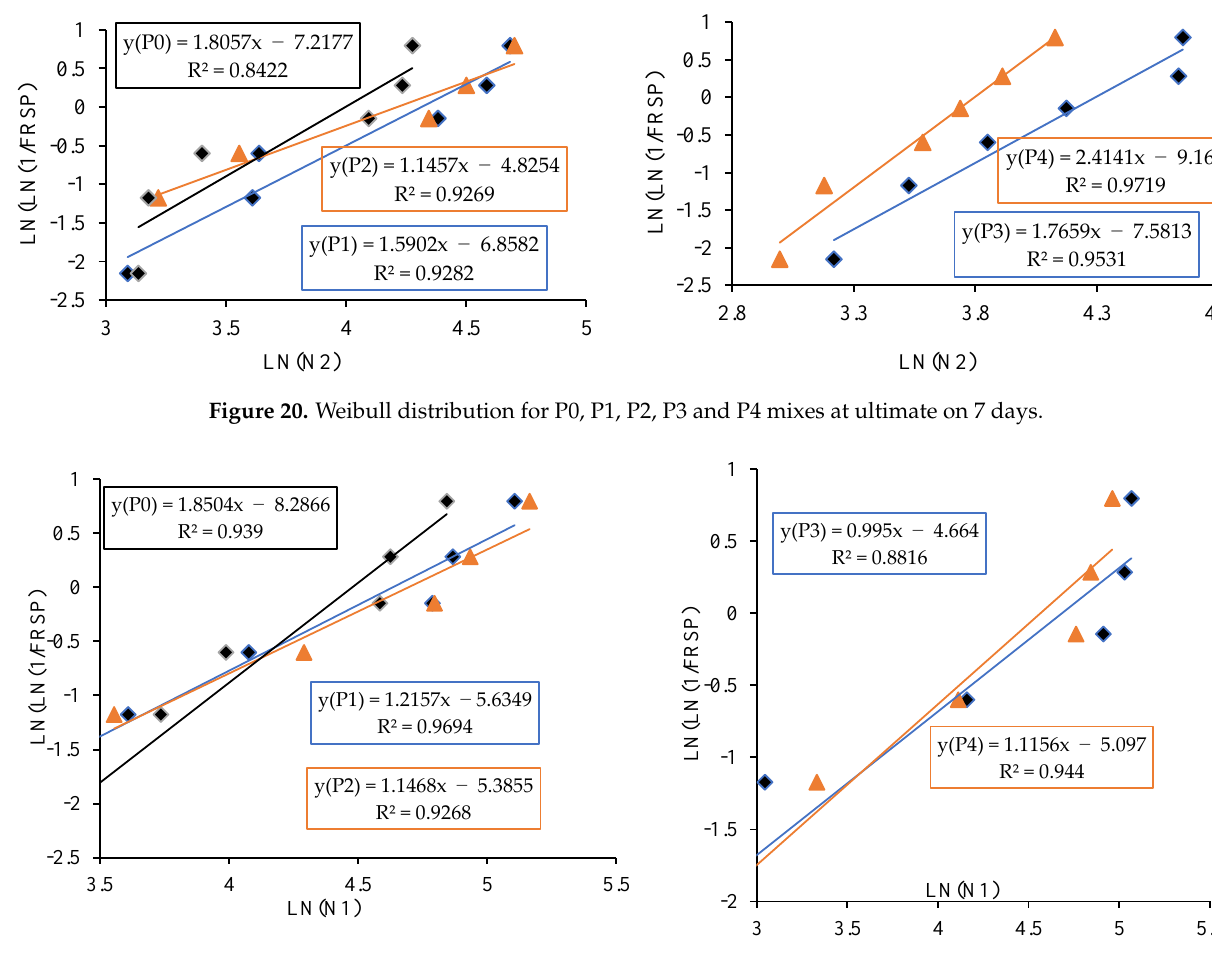
Figure 21. Weibull distribution for P0, P1, P2, P3 and P4 mixes at initial crack on 14 Figure 18. Weibull distribution for P0, P1, P2, P3 and P4 mixes at initial crack on 14 days.